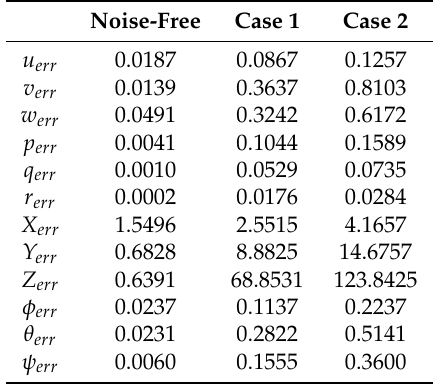
Figure 10. Full tracking errors—flight parameters disturbed by 2 units (Case 2). Table 4. Squared full tracking errors